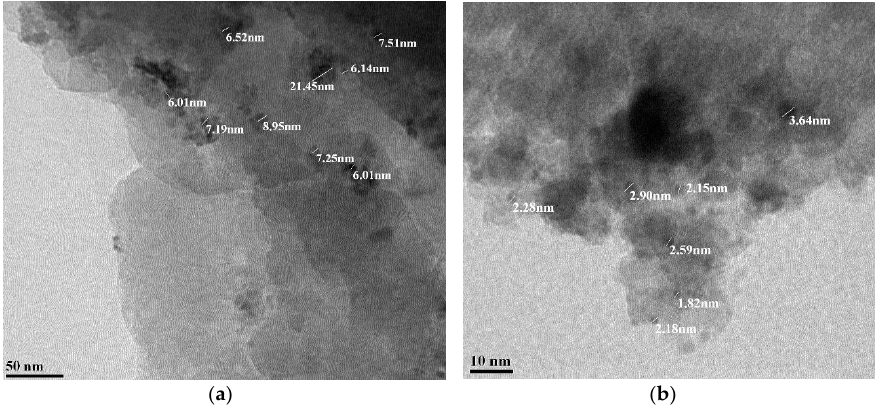
Figure 8. TEM images of ( a ) 2Pd2AuTiSBA and ( b ) 2Pd2AuTiHMS.